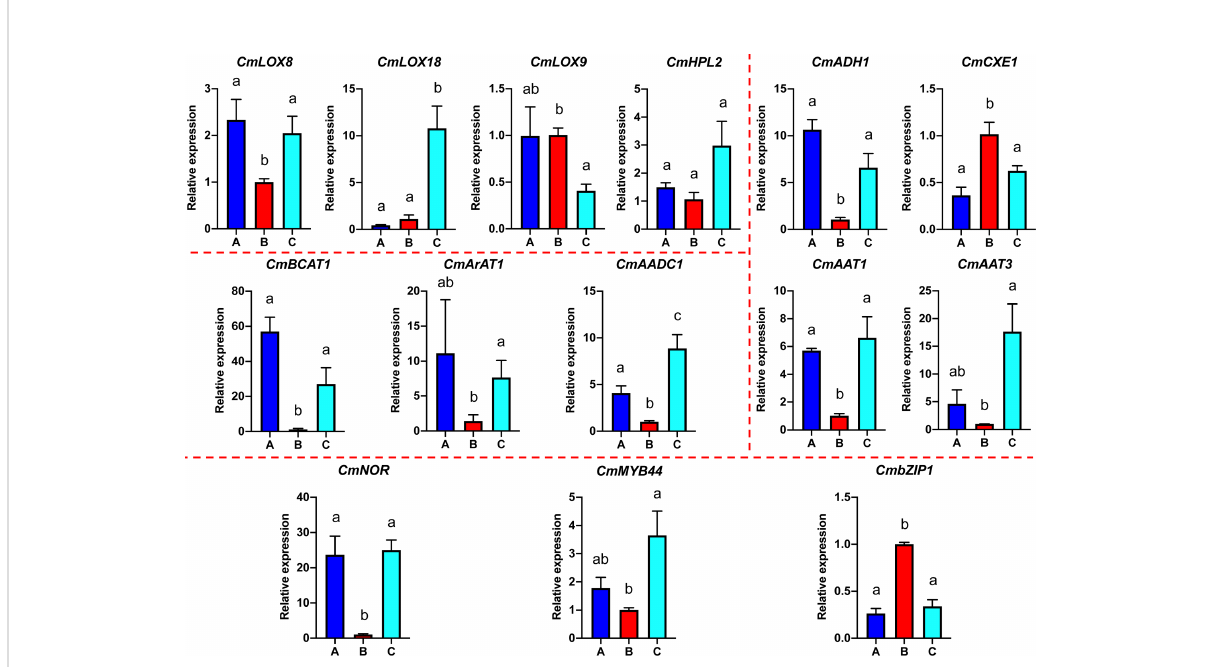
FIGURE 7 Quantitative real-time PCR analysis of select VAE-related DEGs. Signi fi cant differences in gene expression are denoted by different letters ( ± SE, n = 3, p -value <